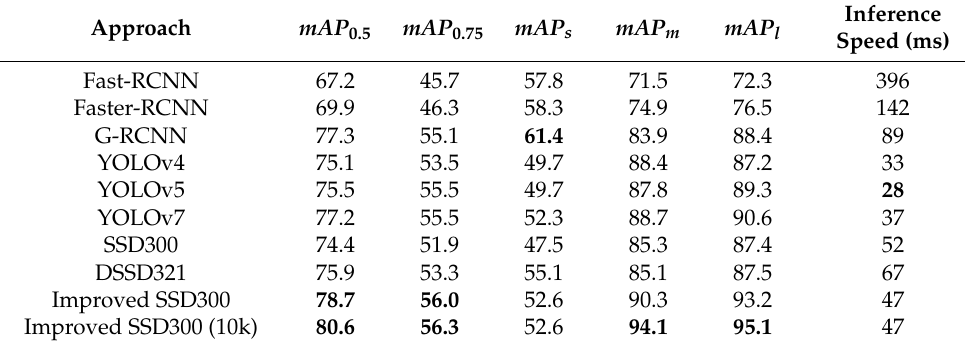
Table 3. Comparison of mainstream methods.